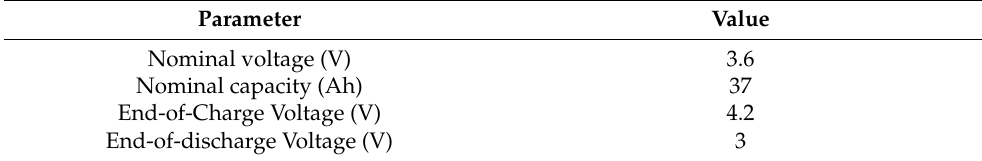
Figure 2. Battery pack configuration. Table 2. Battery parameters.